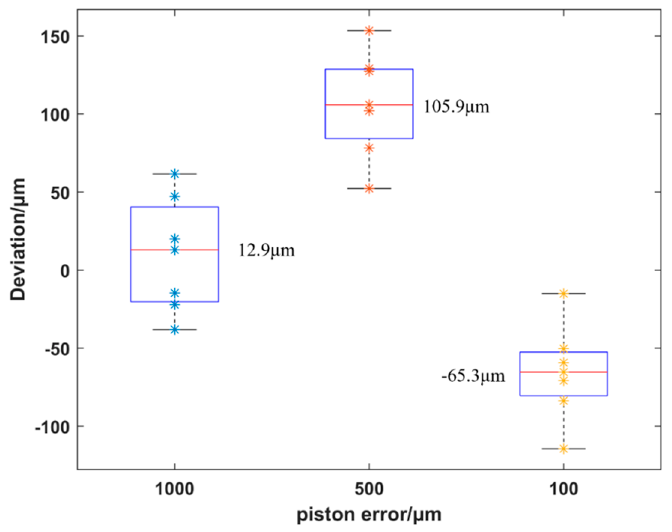
Figure 9. Boxplot of the deviations of the measurement results (4.41